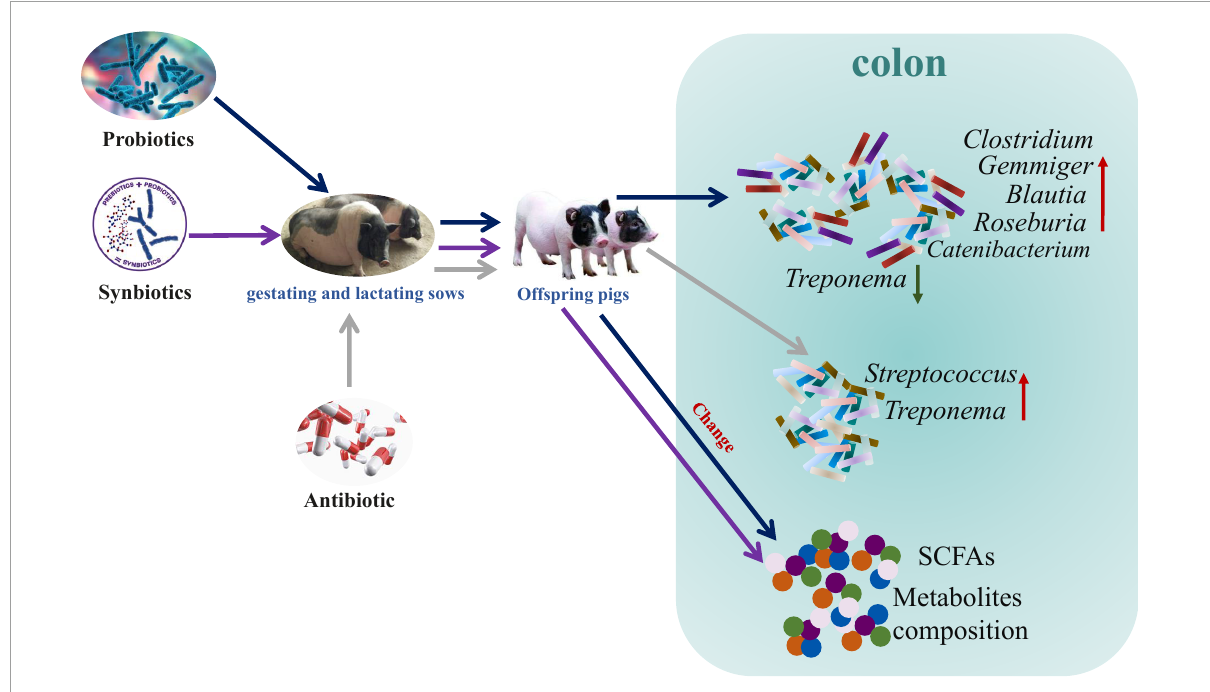
FIGURE13 Schematic presentation of the effects of maternal probiotics and synbiotics addition to sows’ diets on colonic microbiome and metabolome of offspring pigs.